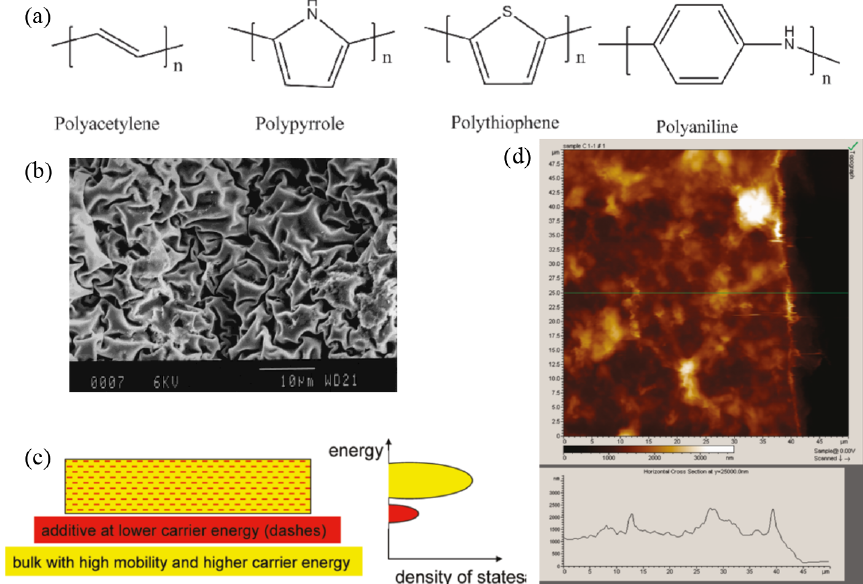
Figure 2. ( a ) Chemical structures of polyacetylene, polyaniline, polypyrrole, and polythiophene. Reproduced from [61] with permission; Copyright John Wiley & Sons, Inc. 2014; ( b ) SEM image of the surface of a polypyrrole film (doped with PF 6 ) that was facing the ITO (indium tin oxide)